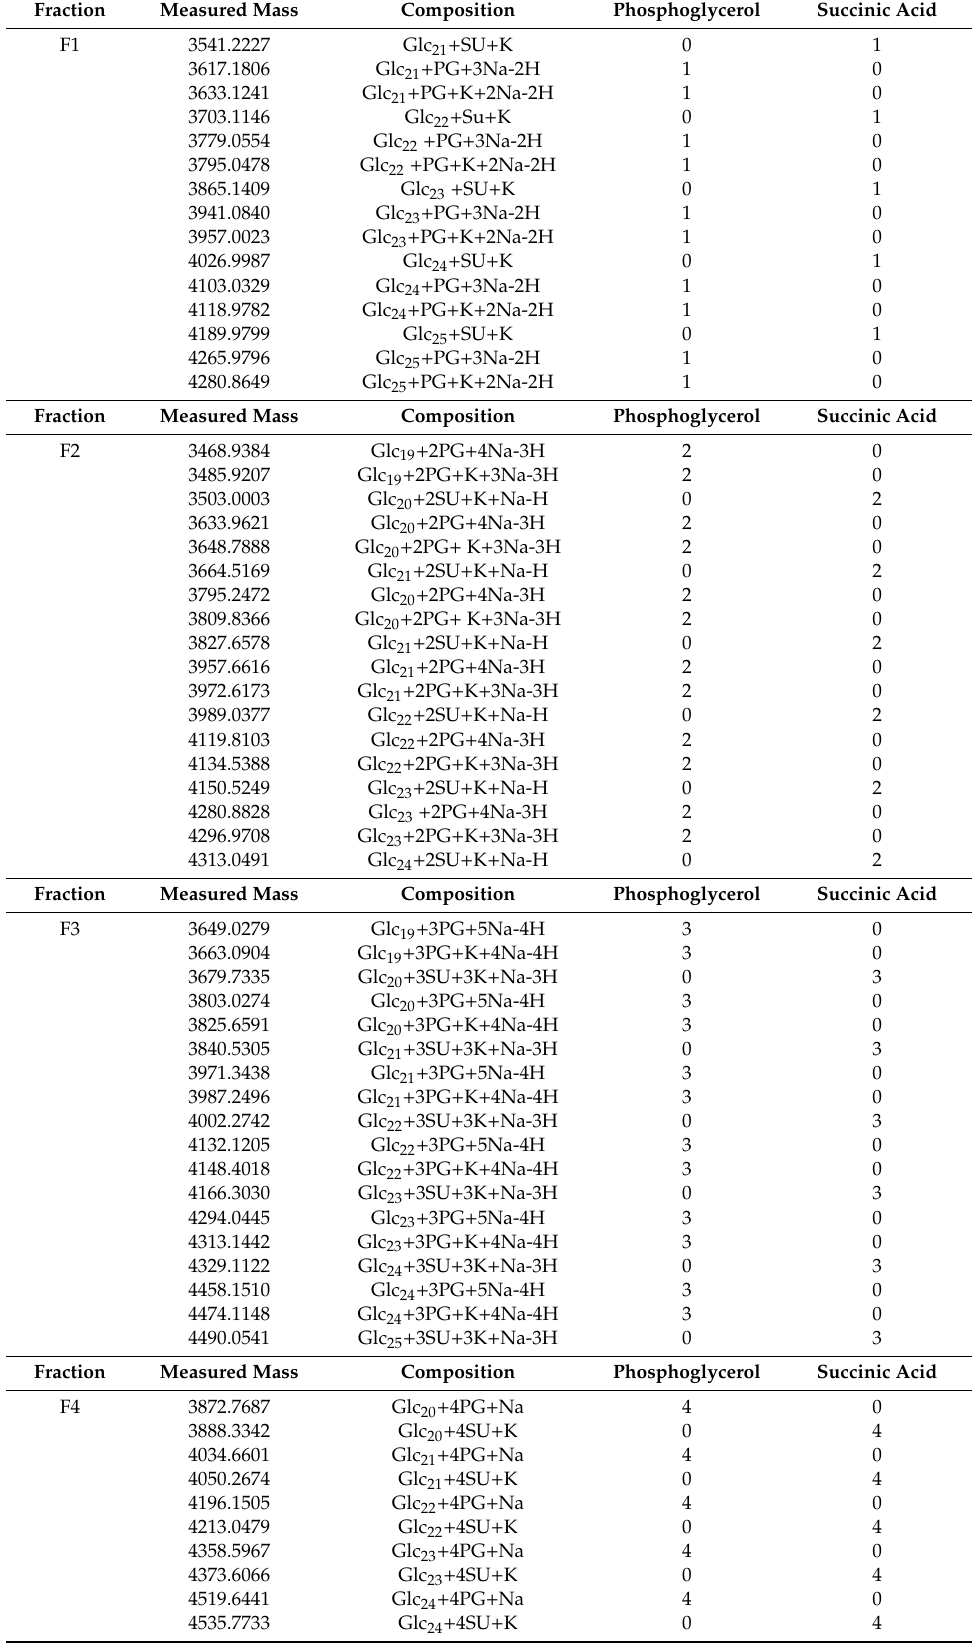
Table 1. MALDI-TOF MS data for F1 fraction, F2 fraction, F3 fraction and F4